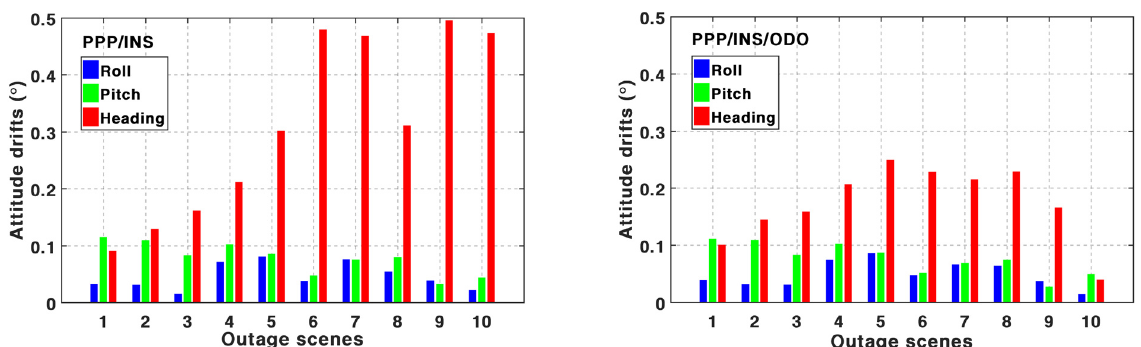
Figure 21. Average of Maximum attitude drifts of different GNSS for BSSD PPP/INS TCI ( left ) and PPP/INS/ODO TCI ( right ) on different GNSS outage scenes.